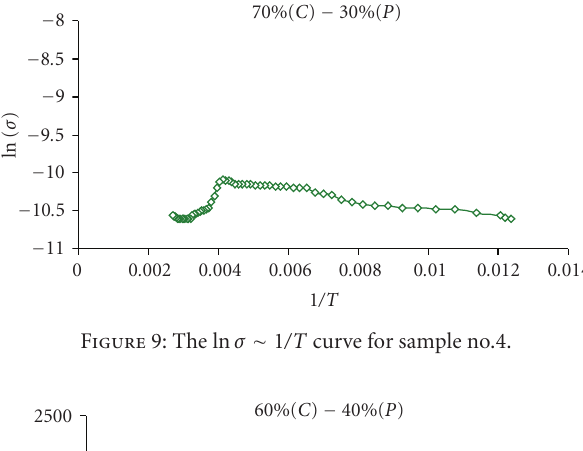
Figure 9: The ln σ ∼ 1 /T curve for sample no.4.